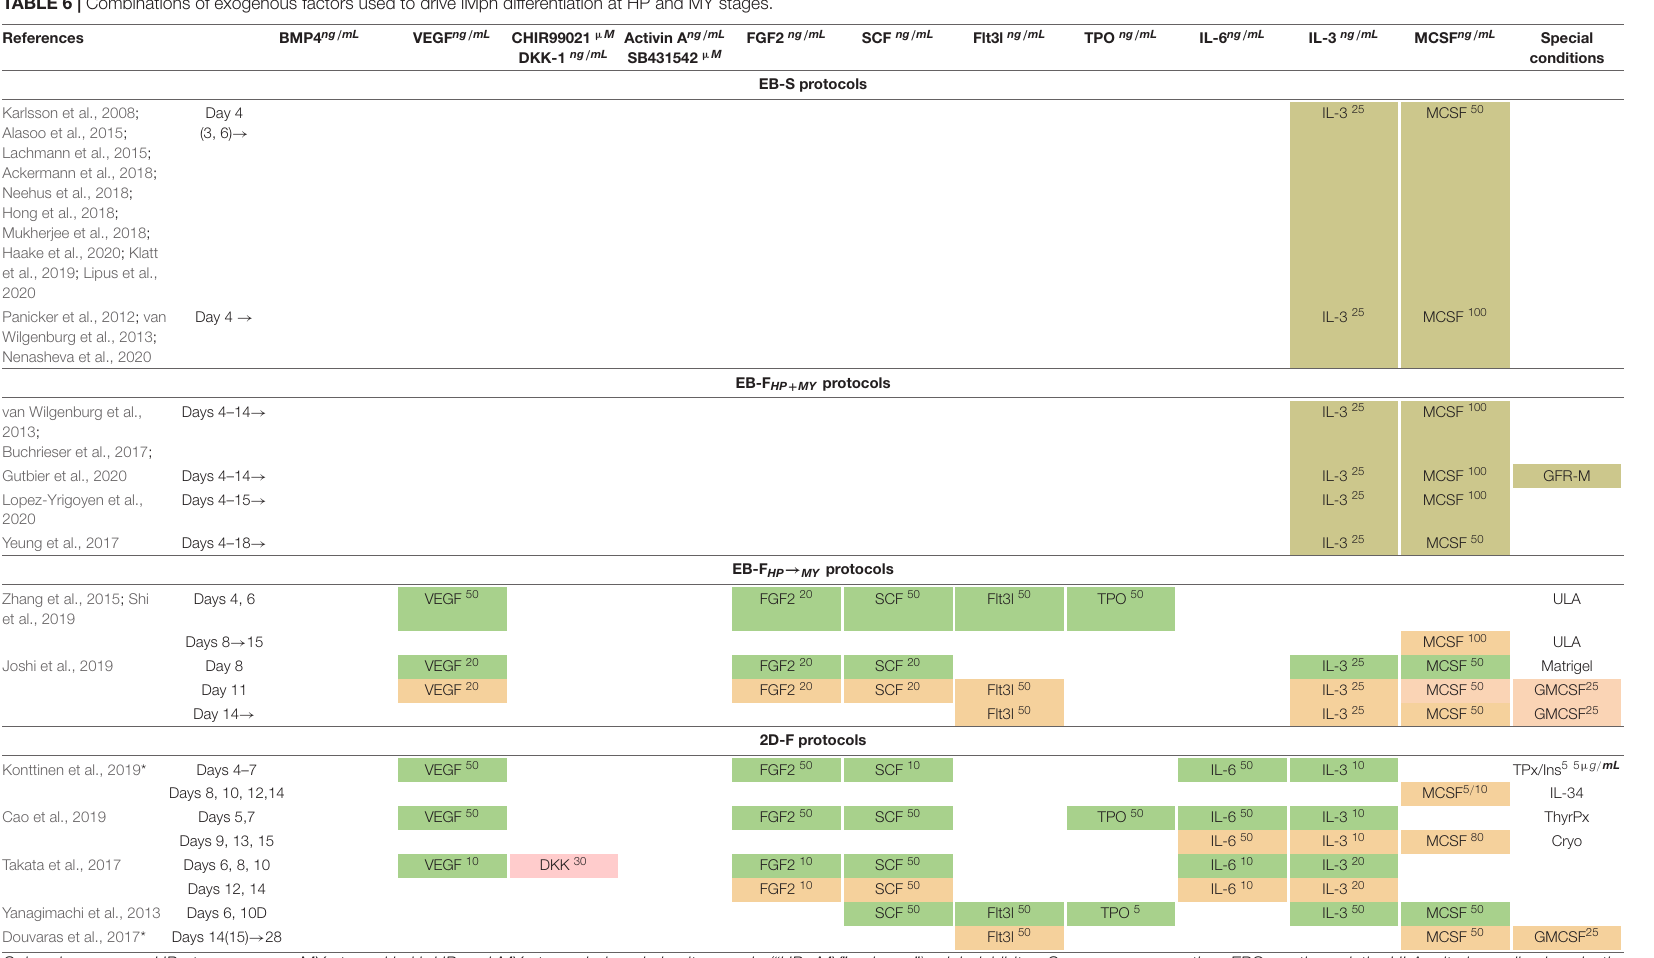
Color clues: green, HP stage; orange, MY stage; khaki, HP and MY stages induced simultaneously (“HP + MY” scheme”); pink, inhibitor. Cryo, cryopreservation; EPO, erythropoietin; ULA, ultralow adhesive plastic; GFR-M, growth factor–reduced Matrigel-coated plates; TPx, thyroid peroxidase; Ins,